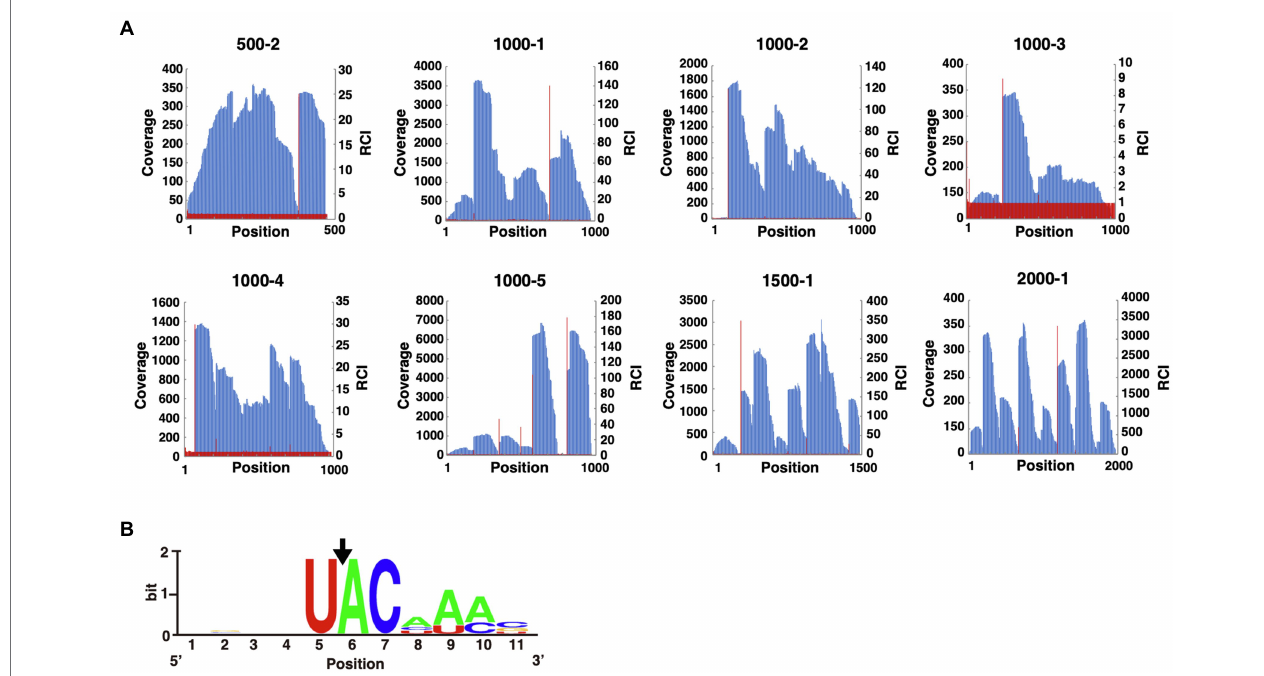
FIGURE 3 | Analysis of the MazF-Da cleavage sequence. (A) The X-axis indicates the nth position from the 5 ' -terminus of the reference sequence. The left side of the Y-axis (blue bar) and the right side of the Y-axis (red line) indicate the coverage and the relative coverage increase (RCI) at each nth position, respectively. (B) WebLogo was used to visualize the aligned sequences upstream and downstream of the nucleotide positions with increased coverage. The position of the nucleotide with a significant increase in coverage was set to six on the X-axis. The sequences used for WebLogo alignment were the ten sequences with the highest RCI. The black arrow indicates the position of the MazF-Da cleavage